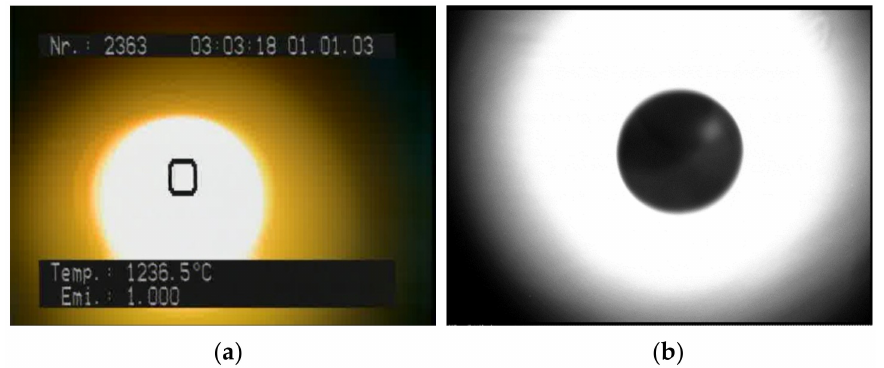
Figure 2. Magnified images of a sample in the ISS-ELF taken by: ( a ) a camera built into the pyrometer (the black square indicates the measuring spot); ( b ) a black and white camera with UV backlighting. The other camera (a black and white camera with a non-telecentric zoom lens) gives a magnified image of a UV backlit sample (Figure 2b). Using the video images (taken at a 60 Hz frequency interval) from this camera, the density of the sample can be